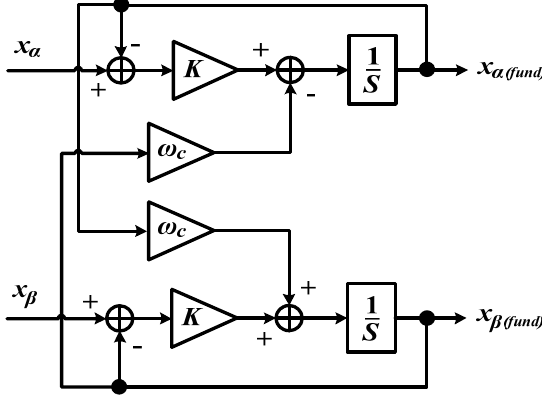
Figure 12. Control structure of self-tuning filter (STF) tuned at specific (cid:2033) (cid:3030) [13,90].